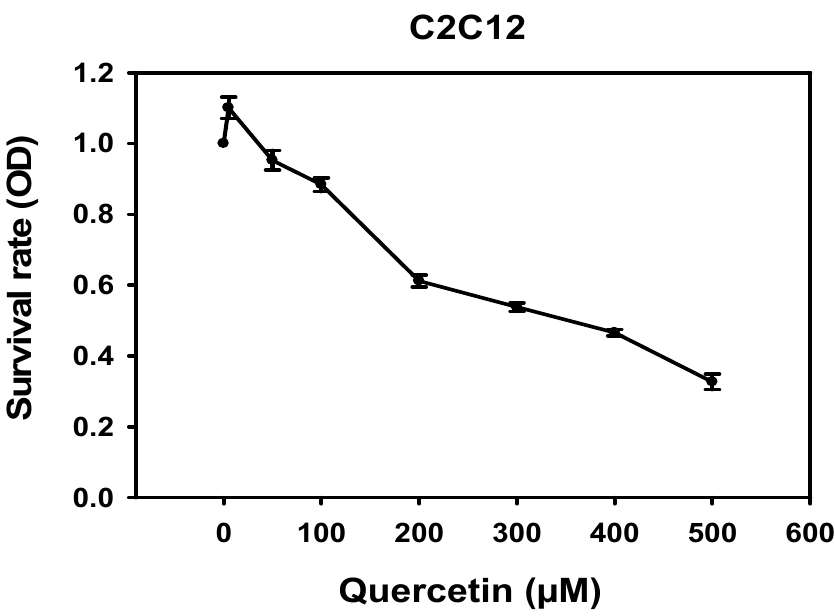
Figure 1. Cytotoxicity of quercetin in C2C12 cells. C2C12 cells were treated with quercetin (0, 5, 50, 100, 200, 300, 400, 500 μ M) for 72 h. MTT assay was used to determine the toxicity. Survival rate diminished sharply starting at 100 μ M. The line graph was created using Sigma plot software.